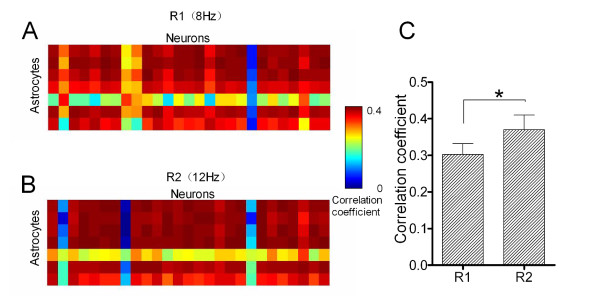
The activity synchrony of barrel neuron-astrocyte pairs is associated with a frequency increase of whisker stimuli. A ~ B) Correlation matrices show the cross-correlations for each of neuron-astrocyte pairs in response (Ca2+ signals) to paired-stimuli, including response one (R1) vs. response two (R2) at 8 Hz (A) and 12 Hz (B) of stimulus frequencies, respectively. Vertical axis in correlation matrix shows for astrocytes and horizonal axis for neurons. C) shows a comparison of correlation coefficients averaged from all active neuron-astrocyte pairs in responses to paired burst-stimuli at 8-to-12 Hz. Asterisk presents p < 0.05 in paired student’s t-test.